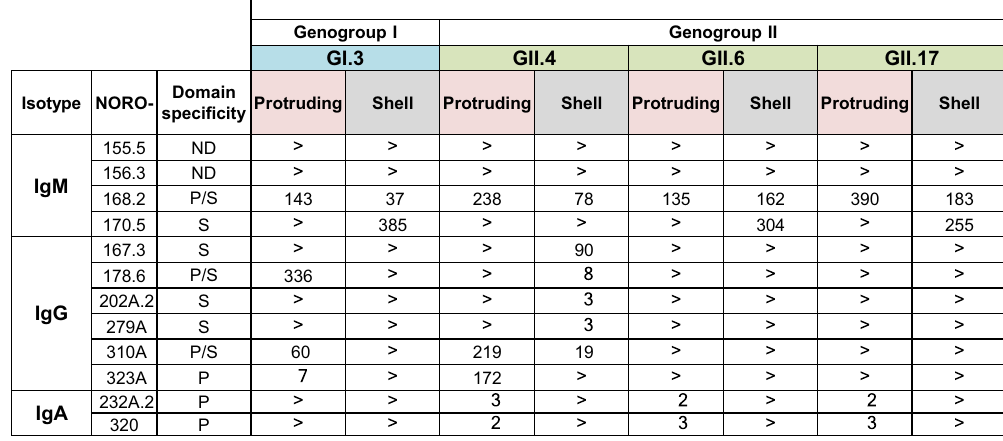
Fig. 3 Half-maximal effective concentrations (EC 50 ) for binding of 12 cross-reactive human mAbs to protruding or shell domain. GI.3, GII.4, GII.6, or GII.17 HuNoV strain protruding or shell domain proteins were used as antigen in an indirect ELISA. The > symbol indicates binding was not detected at the highest concentration tested, 500 nM. ND, not determined; P, protruding domain; S, shell domain; P/S, protruding and shell domain.